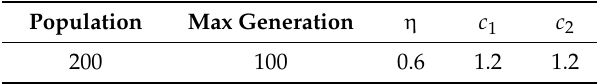
Table 4. The parameter values of the PSO algorithm.